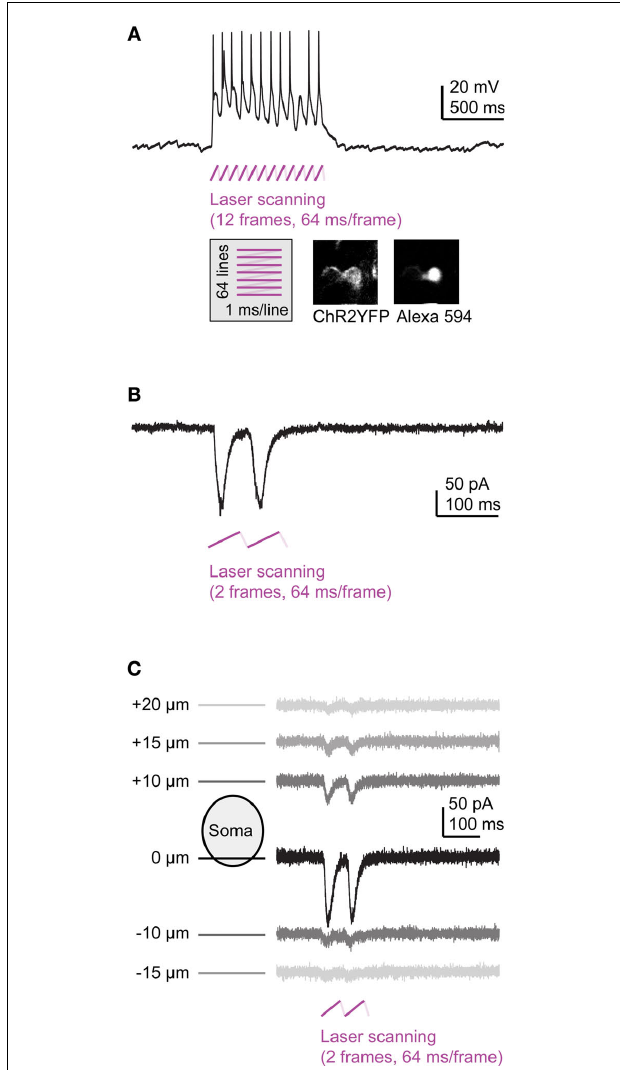
FIGURE 6 | Multiphoton activation of channelrhodopsin-2 in Tet system transgenics. (A) Frame scanning at low laser power evokes a strong depolarization and action potential fi ring (current clamp). (B) Frame scanning evokes inward currents (voltage clamp). (C) Currents evoked by frame scanning as a function of focus